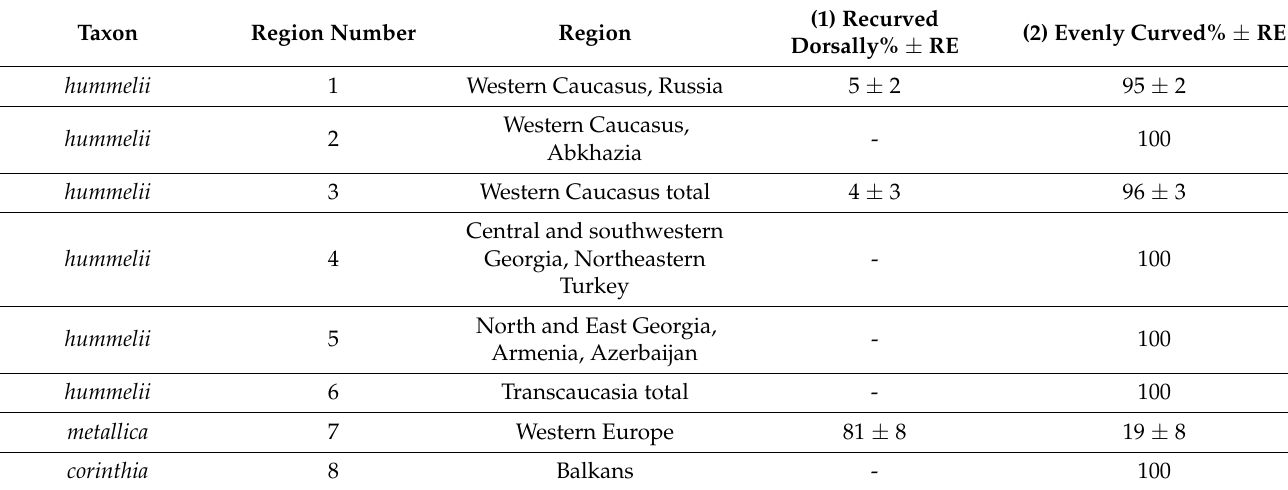
Table 14. Shape of aedeagus apex in lateral view. RE—share representativeness